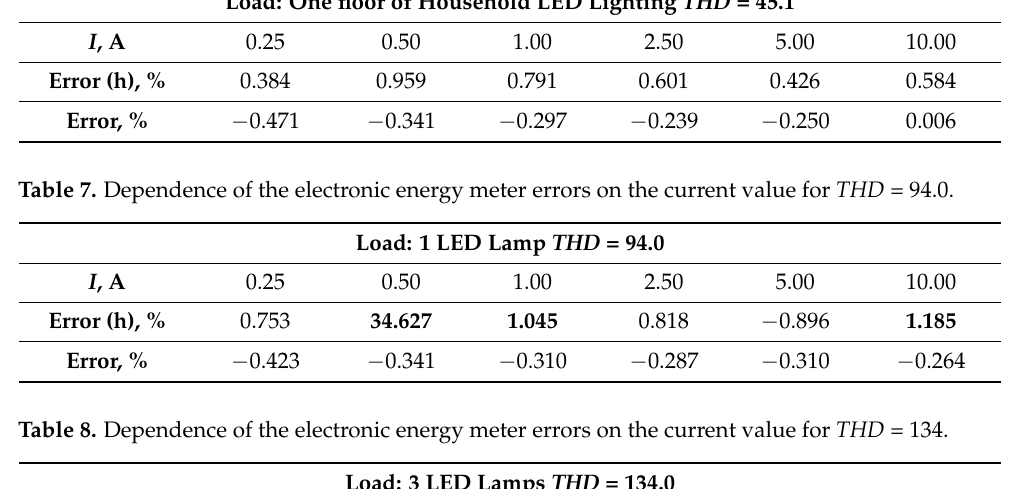
Table 6. Dependence of the electronic energy meter errors on the current value for THD = 45.1. Load: One floor of Household LED Lighting THD = 45.1